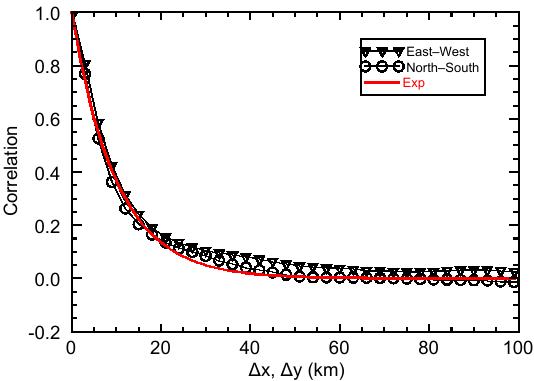
Figure 12. Model error correlation coefficients as a function of hor- izontal distance (cid:49)x or (cid:49)y , which corresponds to east-west (revert triangles) and north–south (blank circles) direction, respectively.